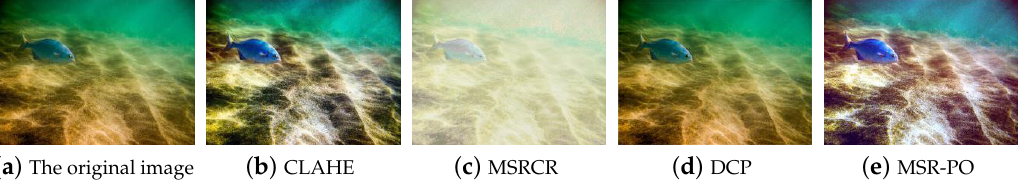
Figure 20. Scene 1 comparison.